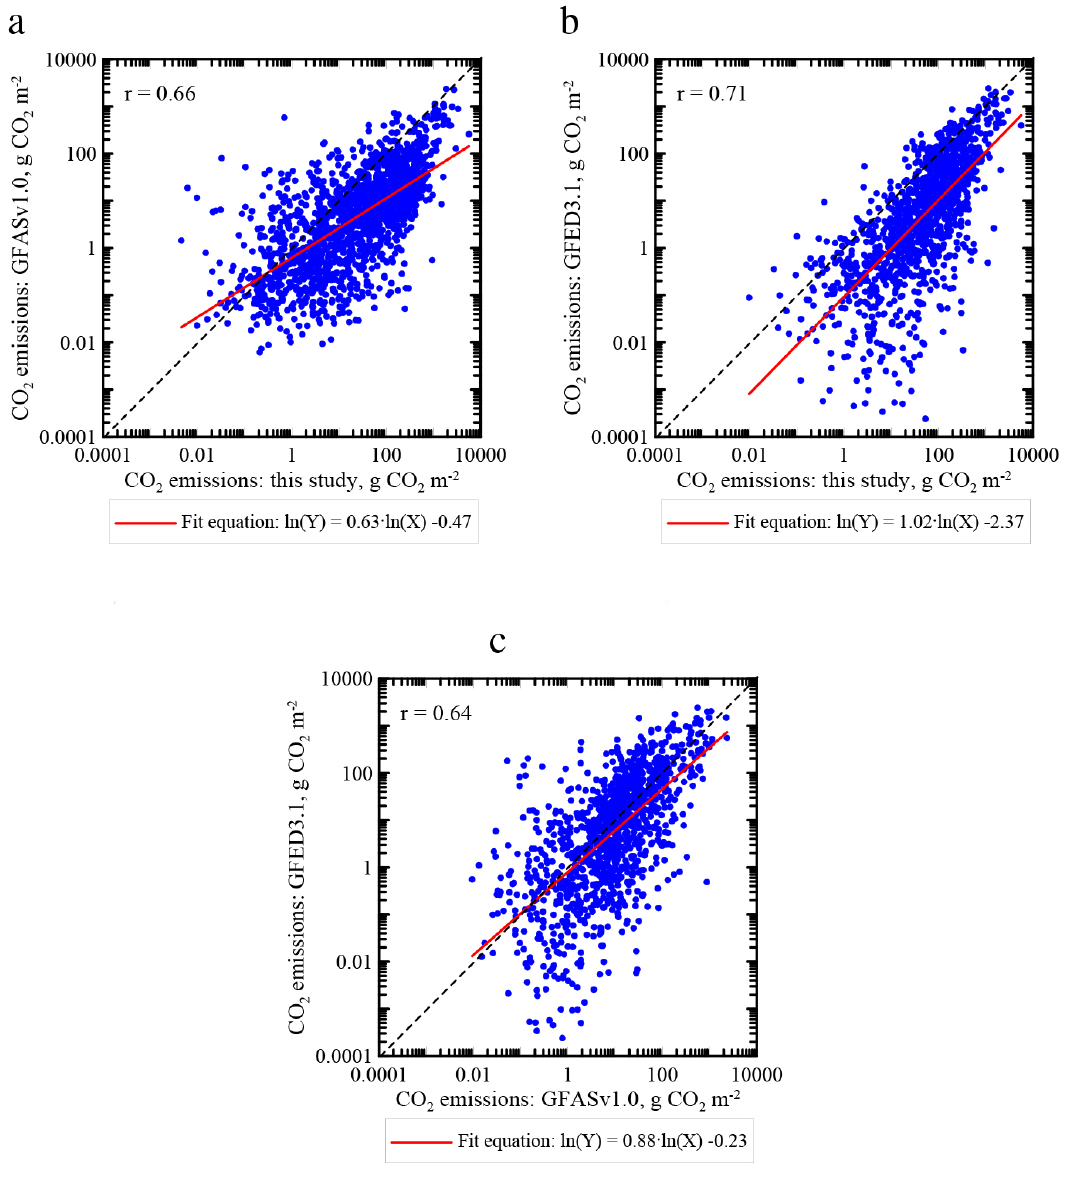
Figure 11. Scatter plots of the gridded CO 2 emissions (see Fig. 10) estimated in this study and obtained from the GFASv1.0 and GFED3.1 inventories for the year 2008. The correlation coefficients (shown on the plots) are calculated for the logarithms of the emission